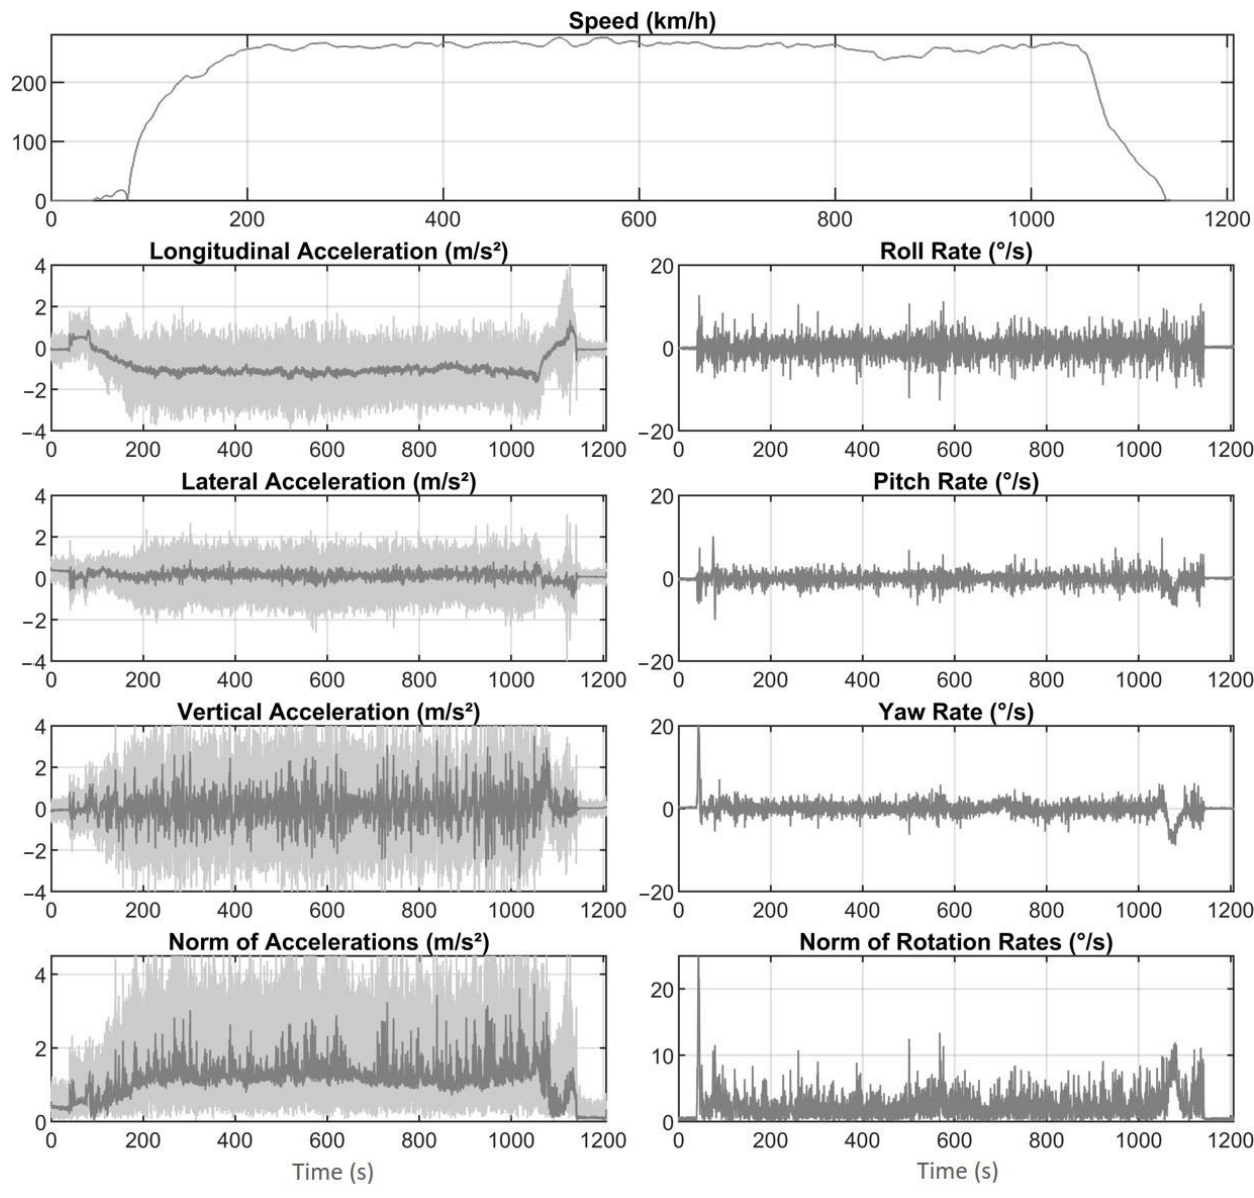
Figure 6. Vehicle dynamics parameters recorded during a helicopter trip—speed, filtered accelera- tions, rotational rates.